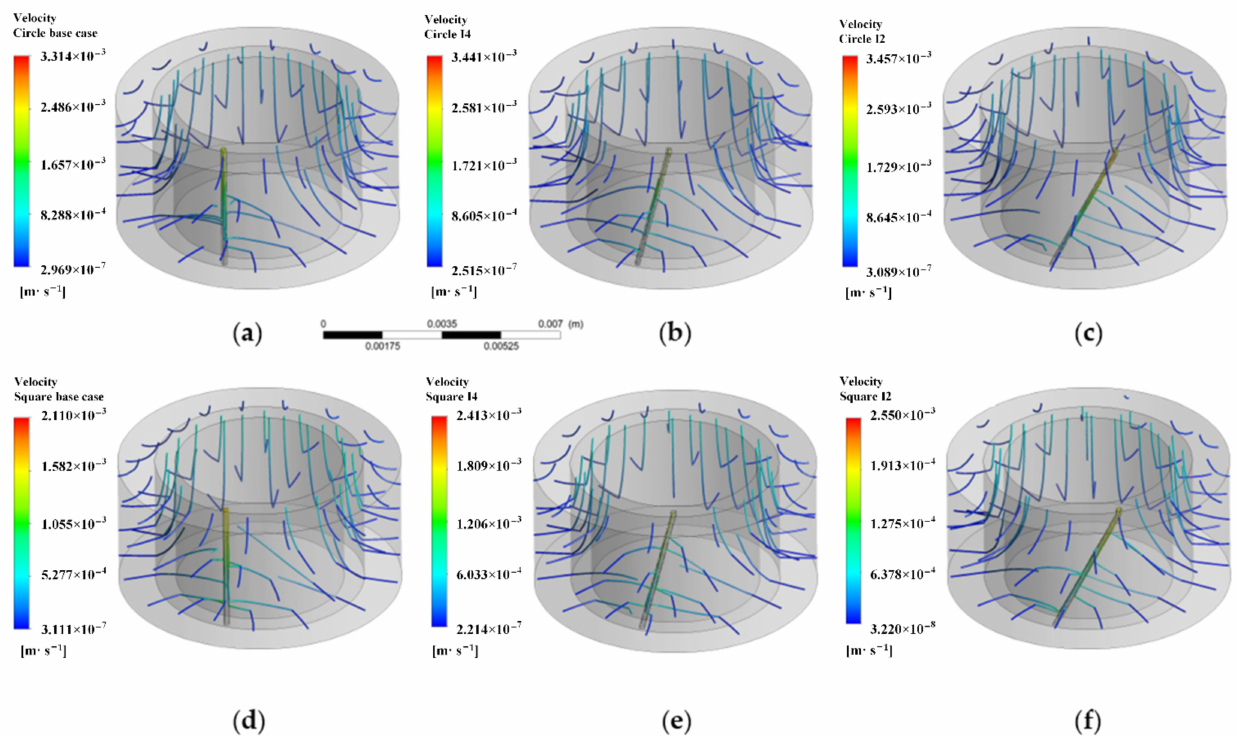
Figure 17. The velocity streamlines for vertical and slanted microchannel cases: ( a ) circular 0 ◦ , ( b ) circular 13.89 ◦ , ( c ) circular 25.82 ◦ , ( d ) square 0 ◦ , ( e ) square 13.89 ◦ , ( f ) square 25.82 ◦ .